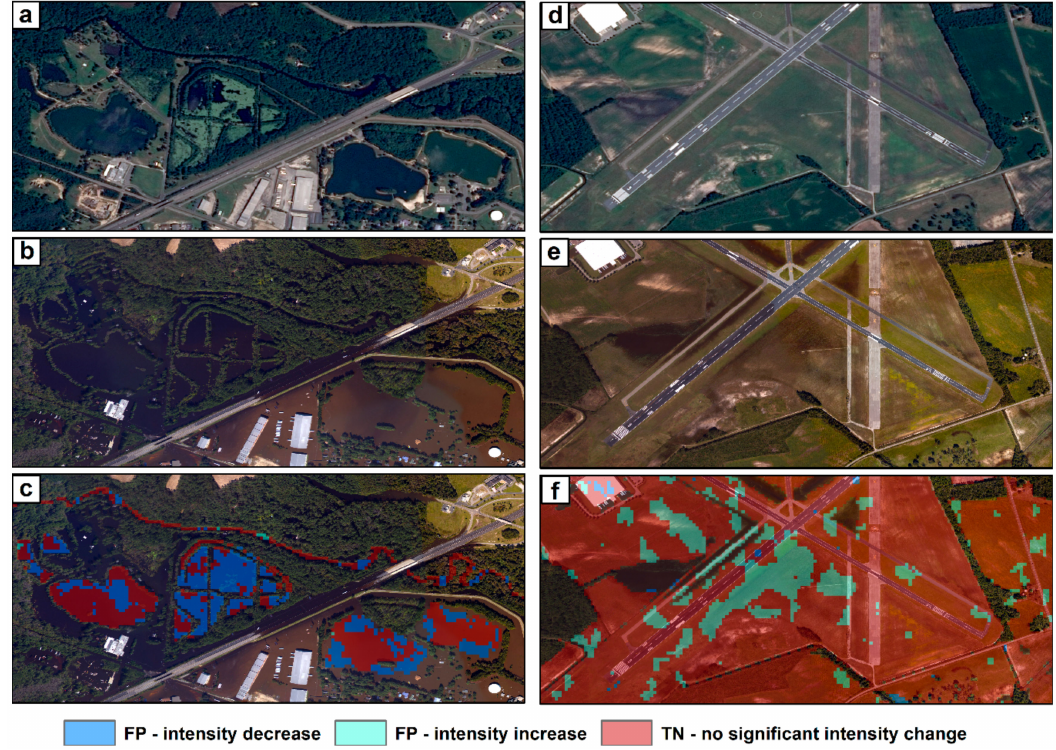
Figure 13. The ( a ) pre-event optical image and ( b ) during-event aerial photo for patch 3. See Figure 6a for location. ( c ) The contingency map for the Flood class. ( d – e ) Same as ( a – b ) for patch 4. ( f ) The contingency map for the Dry